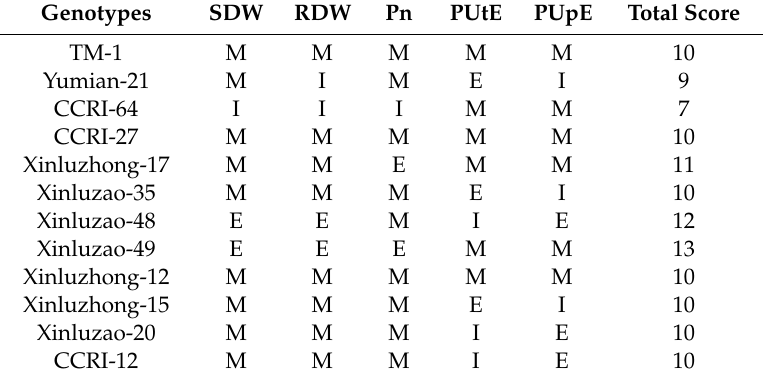
Table 8. Classification of cotton genotypes (grown at P starvation; 0 µ M KH 2 PO 4 ) based on their index scores of various parameters into e ffi cient (E), medium (M), and ine ffi cient (I) scoring genotypes.